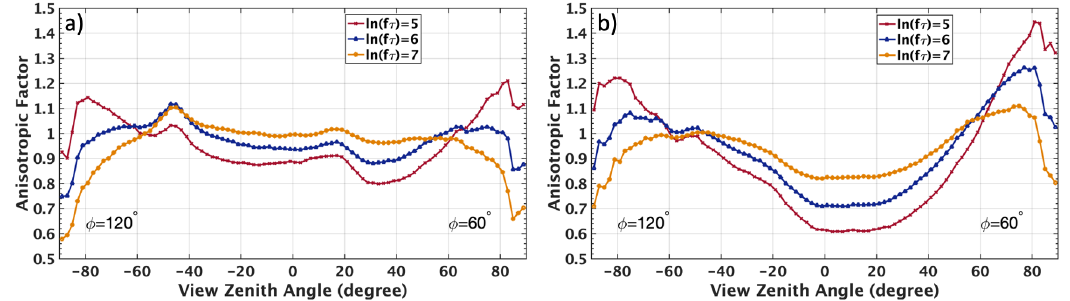
Figure 4. SW anisotropic factors for solar zenith angles of 30 ◦ ( a ) and 50 ◦ ( b ) for three ln ( f τ ) values for liquid clouds over ocean at relative azimuth angle of 60 ◦ and 120 ◦ . Here f is the cloud fraction in %, and τ is the cloud optical